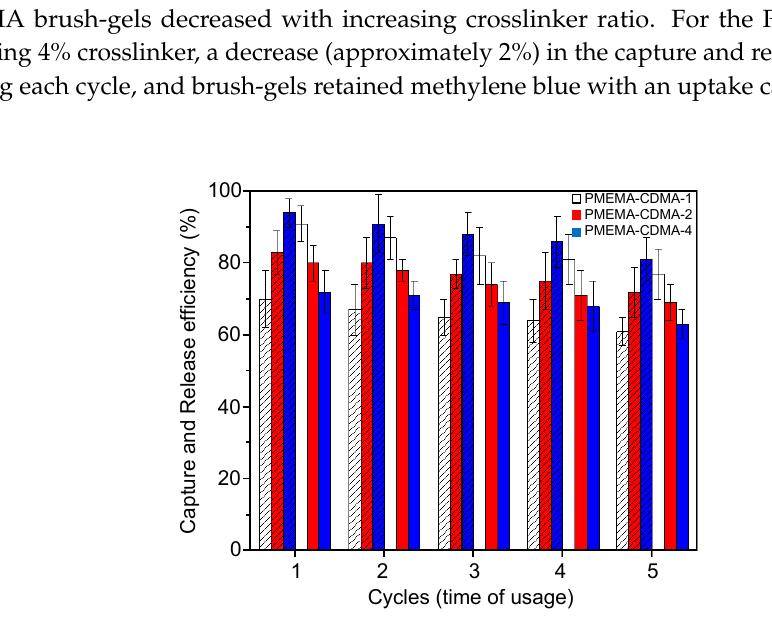
Figure 5. Capture (patterned) and release efficiency of PMEMA brush-gels with methylene blue in repeated cycles.